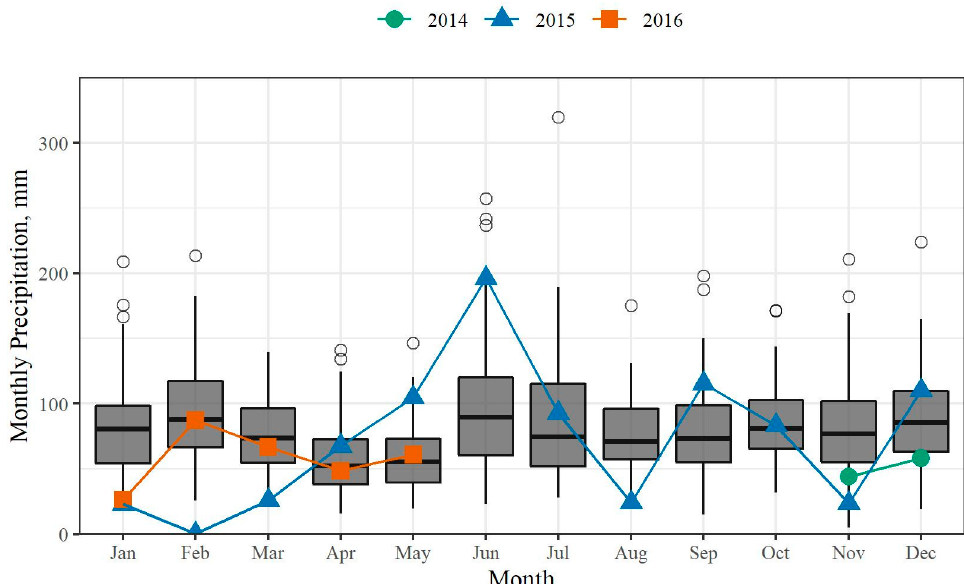
Figure 4. Tukey box and whiskers plots for the monthly historical precipitation between 1950 and 2010 as recorded at the Syracuse Hancock International Airport [19]. The bottom and top of the box represent the first and third quartiles, and the band inside the box represents the median; whiskers are presented in the style of Tukey [25–27]. Data not included in the whiskers are plotted as outliers. Monthly rainfall as recorded at the OnCenter green roof between November 2014 and May 2016 are reported as colored lines. Snow is not included in monthly totals at the OnCenter green roof but is included in the historic averages recorded at the airport. Months where rainfall is recorded for only part of the month (14–31 October 2014 and 1–16 June 2016) are included in the monitoring period but are not included on this plot.